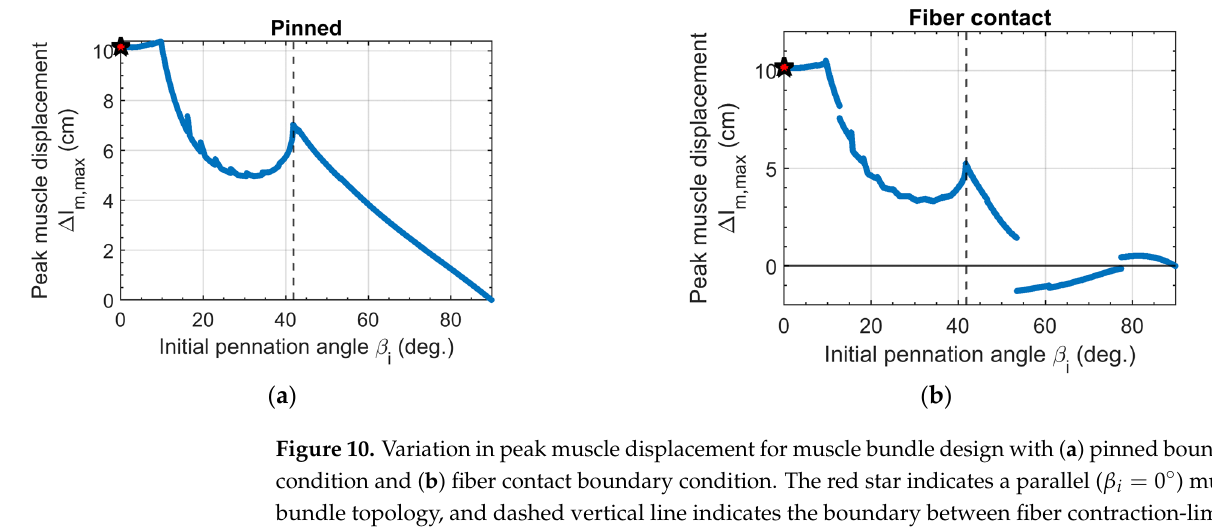
Figure 10. Variation in peak muscle displacement for muscle bundle design with ( a ) pinned bound- ary condition and ( b ) fiber contact boundary condition. The red star indicates a parallel ( 𝛽 (cid:3036) = 0° ) muscle bundle topology, and dashed vertical line indicates the boundary between fiber contraction- limited (left of the line) and fiber rotation-limited (right of line) topologies.